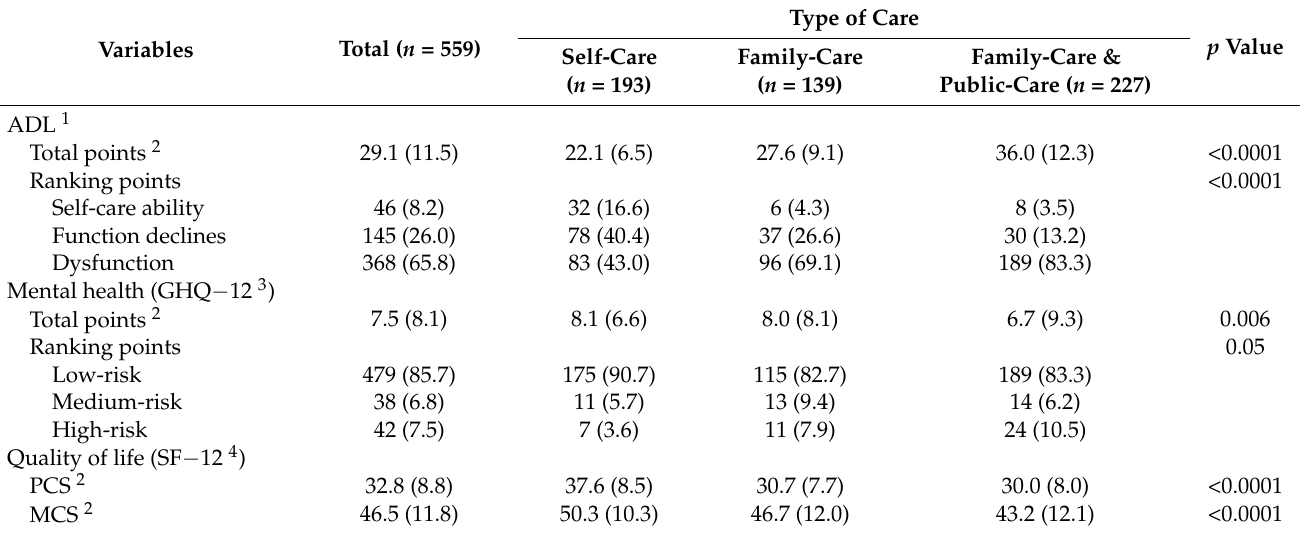
Table 3. Health outcomes of disabled elderly in different types of care.